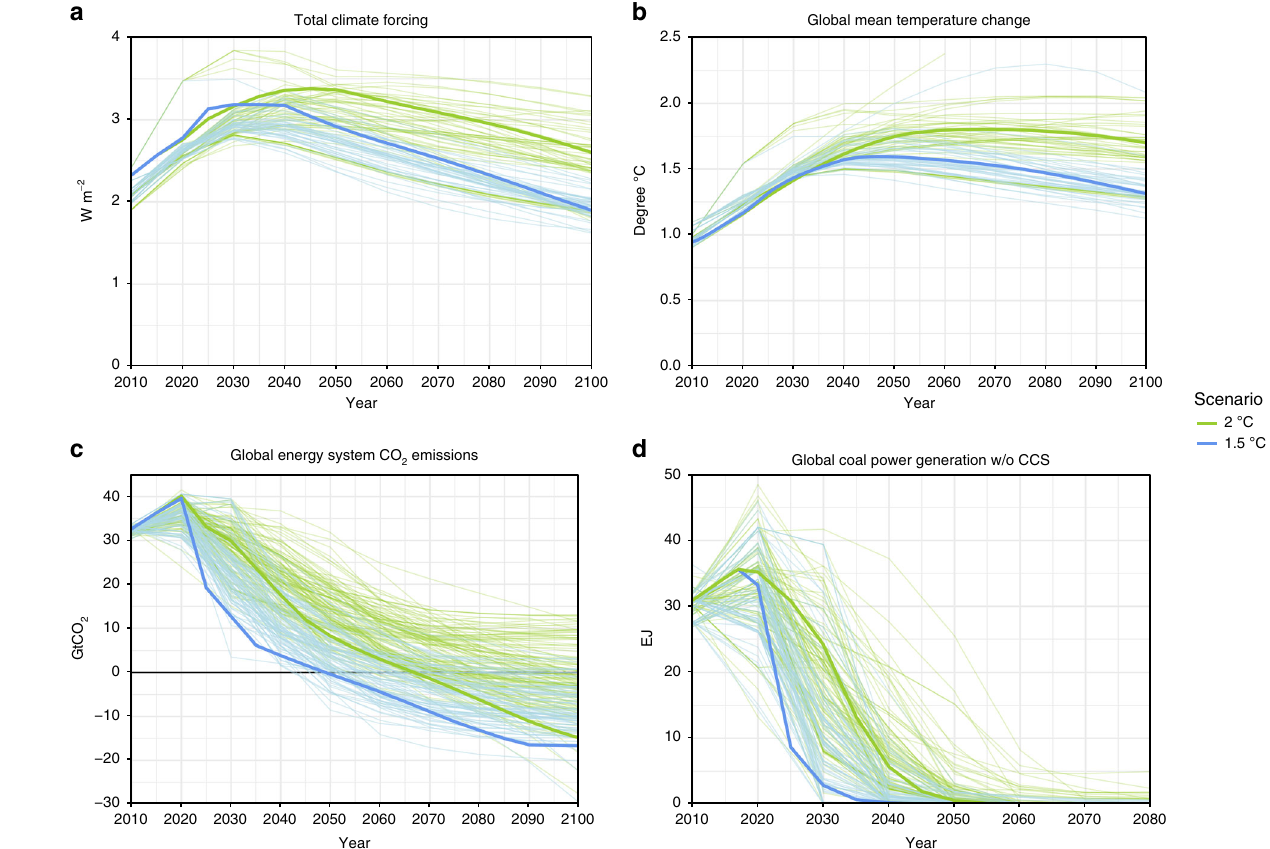
Fig. 4 Well-below 2 °C and 1.5 °C scenarios. We compare our scenarios with others in the literature in terms of total climate forcing ( a ), global mean temperature change ( b ), global energy-related CO 2 emission pathways ( c ), and global coal power generation pathways ( d ). The lighter lines are scenarios from the IAMC 1.5 °C Scenario Explorer 67 . The light blue lines indicate scenarios categorized as below 1.5 °C and 1.5 °C low overshoot, and the light green lines indicate scenarios categorized as lower 2 °C in the